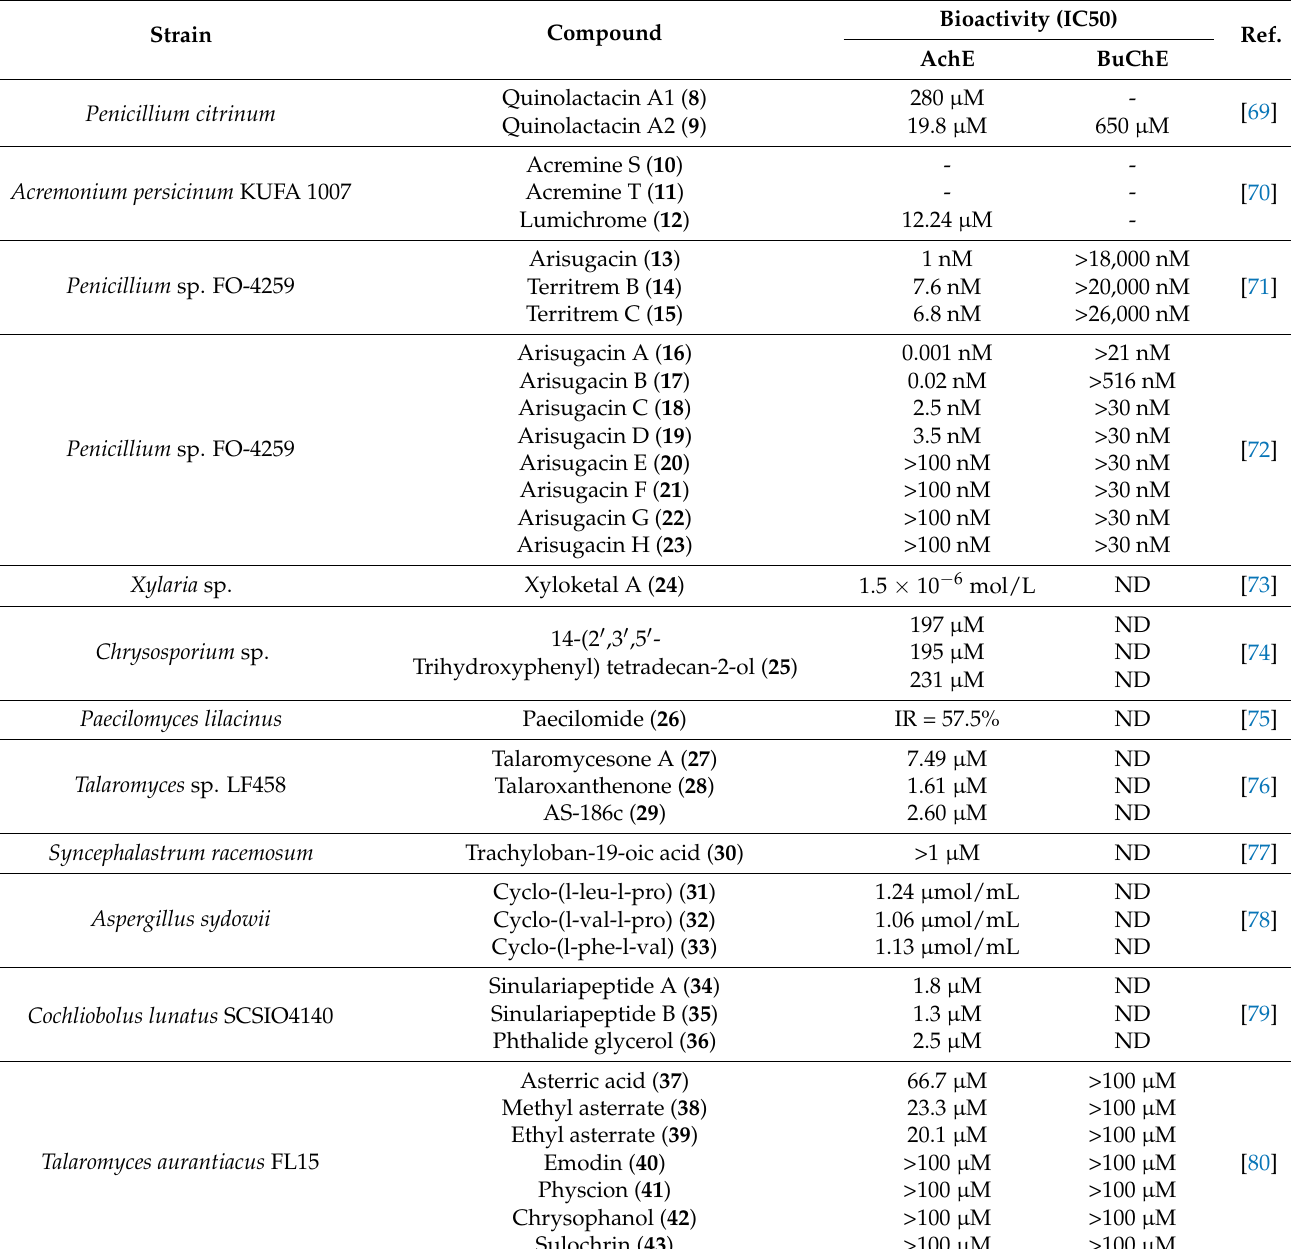
Table 2. The cholinesterase (ChE) inhibitors from